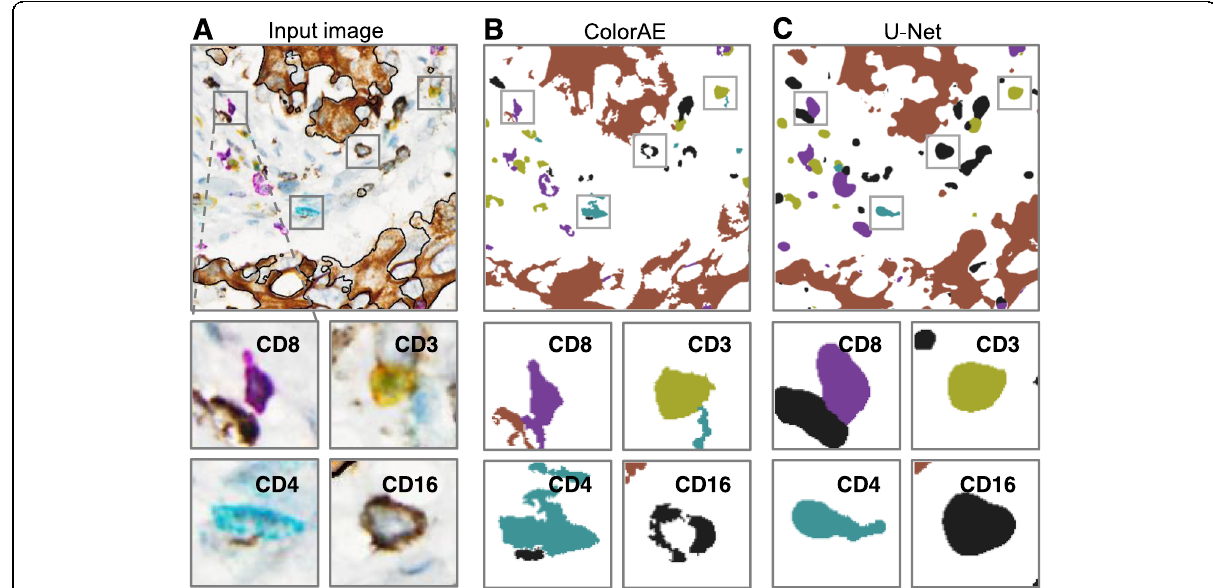
Fig. 4 ColorAE and U-Net predictions. A . mIHC input image of tumor microenvironment, with a representative cell from each class of immune cells (magnified below). B - C . ColorAE and U-Net prediction masks based on the original